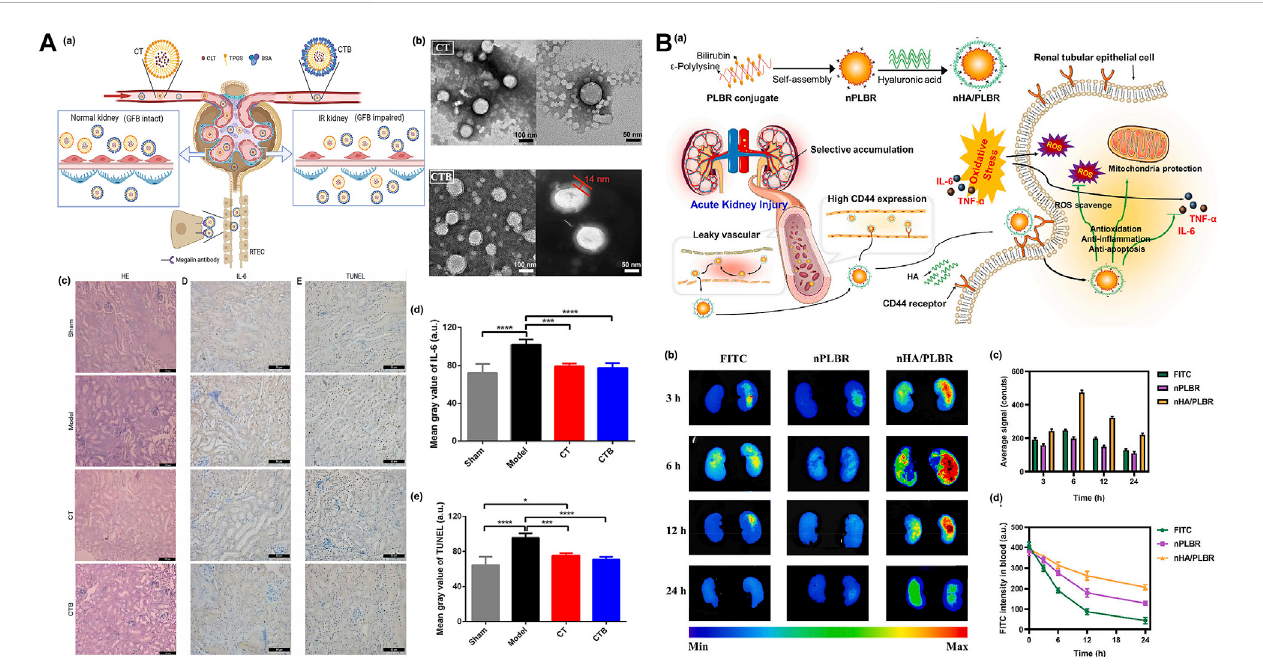
FIGURE 8 (A)(a) SchematicdiagramoftheactionofCLT-TPGSnanocomposite(CT)inIR-AKImice.GFB,glomerular fi ltrationbarrier;RTEC,renal tubularepithelial cells, (b) Transmission electron microscope (TEM) images of CT or CTB, (c) The results of H-E staining, representative images of IL-6 expression, and TUNEL method were used to detect the apoptosis of renal cells in different groups, (d) Semi-quantitative results of IL-6 expression, (e) Semi-quantitative results of renal cell apoptosis. Adapted with permission from (J. Control. Release 2022, 349, 401 – 412.) (Qin et al., 2022); (B) (a) nHA/PLBR can accumulate in damagedrenaltubularepithelialcellsbytargetingCD44, (b) Renal fl uorescenceintensityofAKIratmodelstreatedwiththreedifferentdrugs, (c)